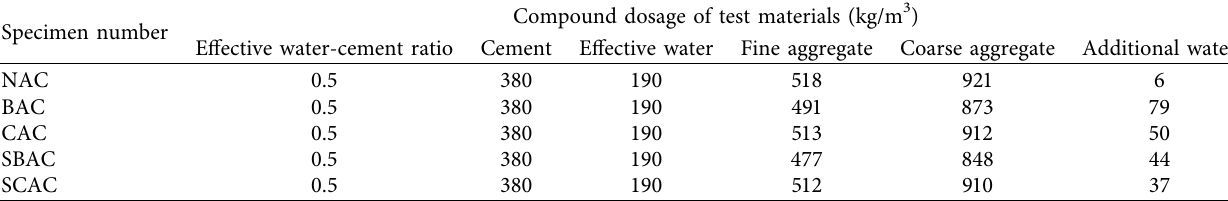
Figure 1: Concrete Table 2: Mix ratio of concrete.